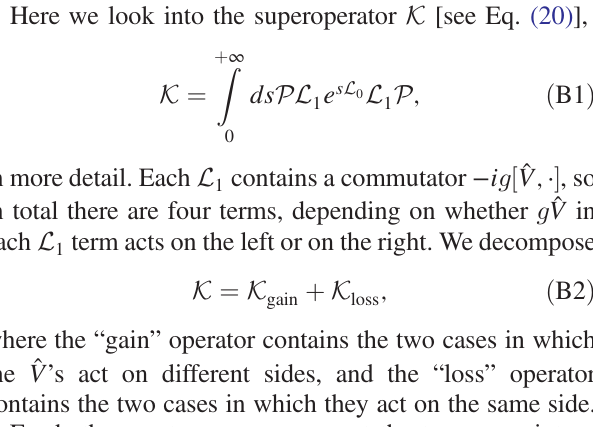
τ Þ in the basis of ˆ H FIG. 8. Projected dynamics of m 0 at three k ð ˆ H → ˆ H 0 . 12 . We compare times after the quench 1 , with g 1 ¼ I results for the projected dynamics within the diagonal ensemble (Projected DE), also reported in Fig. 5, with those obtained within the grand canonical ensemble (Projected GE). The temperature and the chemical potential of the grand canonical ensemble are set so that the energy density e 0 and the particle filling n in this ensemble match those in the diagonal ensemble. The results reported are for the 16th order of the